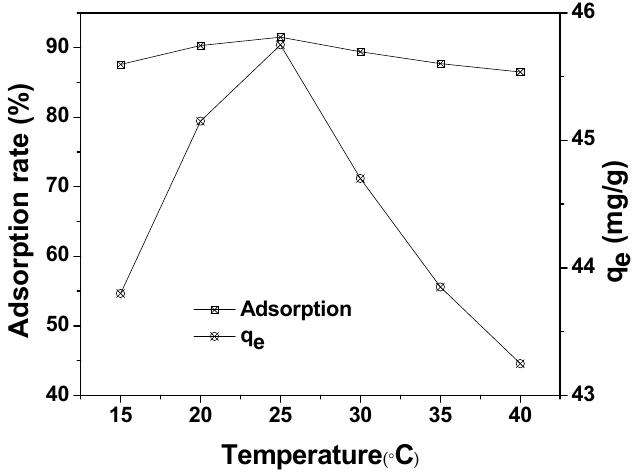
Figure 9. Effect of reaction temperature on the adsorption of MAFC to emulsified oil ( emulsified oil 100 mg/L, contact time 30 min, and MAFC 0.1 g).